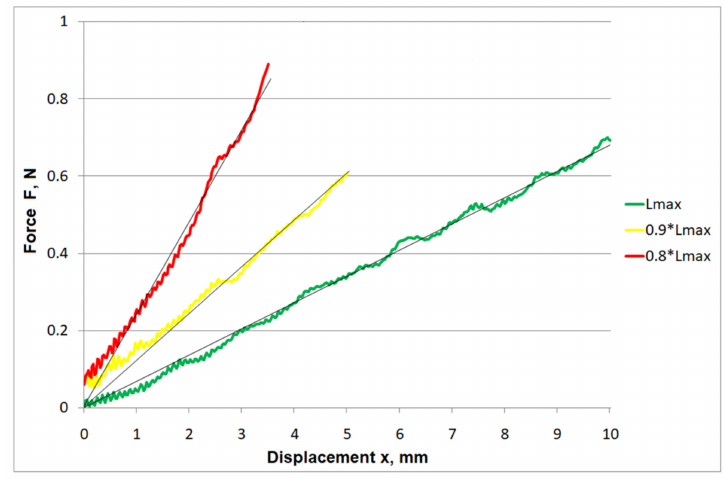
Figure 6. The aggregated F(x) chart for all cutting elements. Examples of force–displacement characteristics for a single cutting element for differ- ent levels of protrusion are presented in Figure 7.